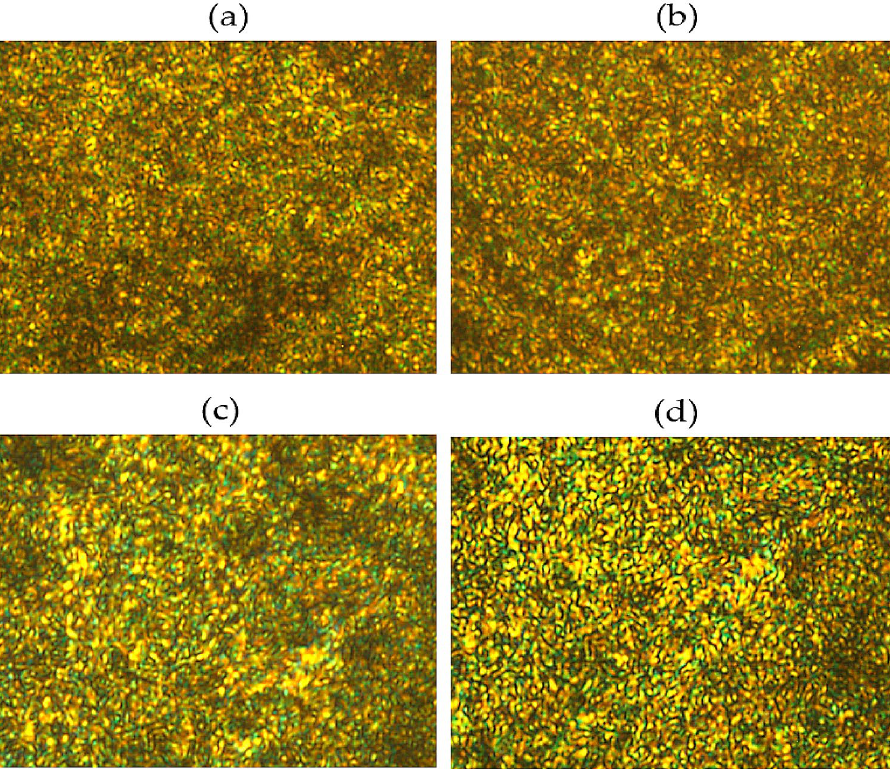
Figure 5. Polarized optical micrographs of TLCP fibers with various heat treatment times (magnification 200×): ( a ) 230/3, ( b ) 230/6, ( c ) 230/9, and ( d )